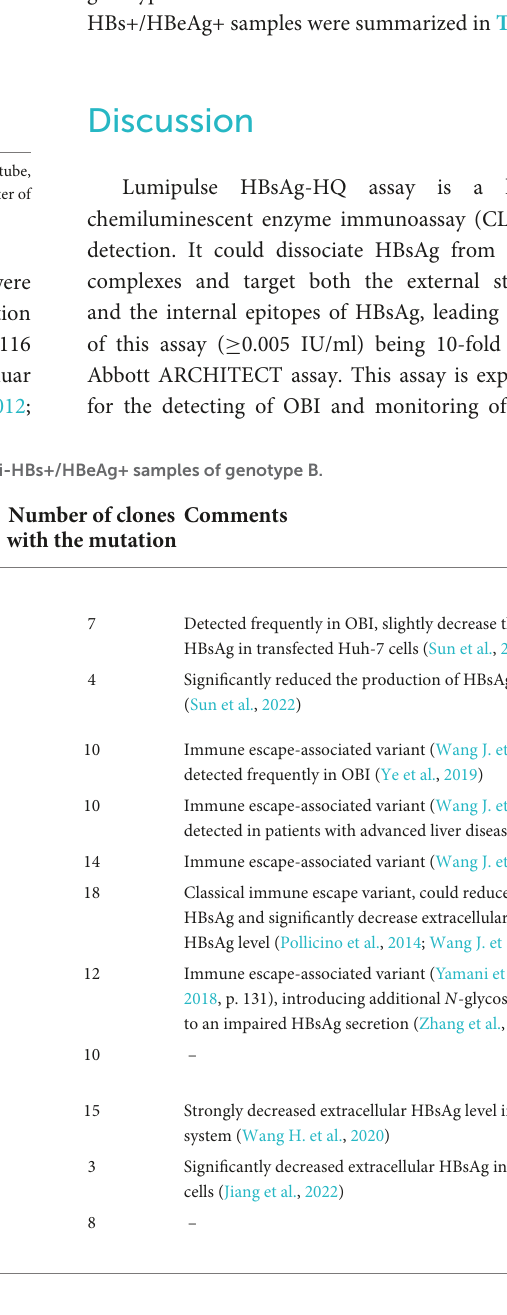
a HBsAg-T and HBsAg-C represent the HBsAg titer of the test tube and control tube, respectively;HBsAgT-CequalstheHBsAgtiterofthetesttubeminustheHBsAgtiterof thecontroltube.